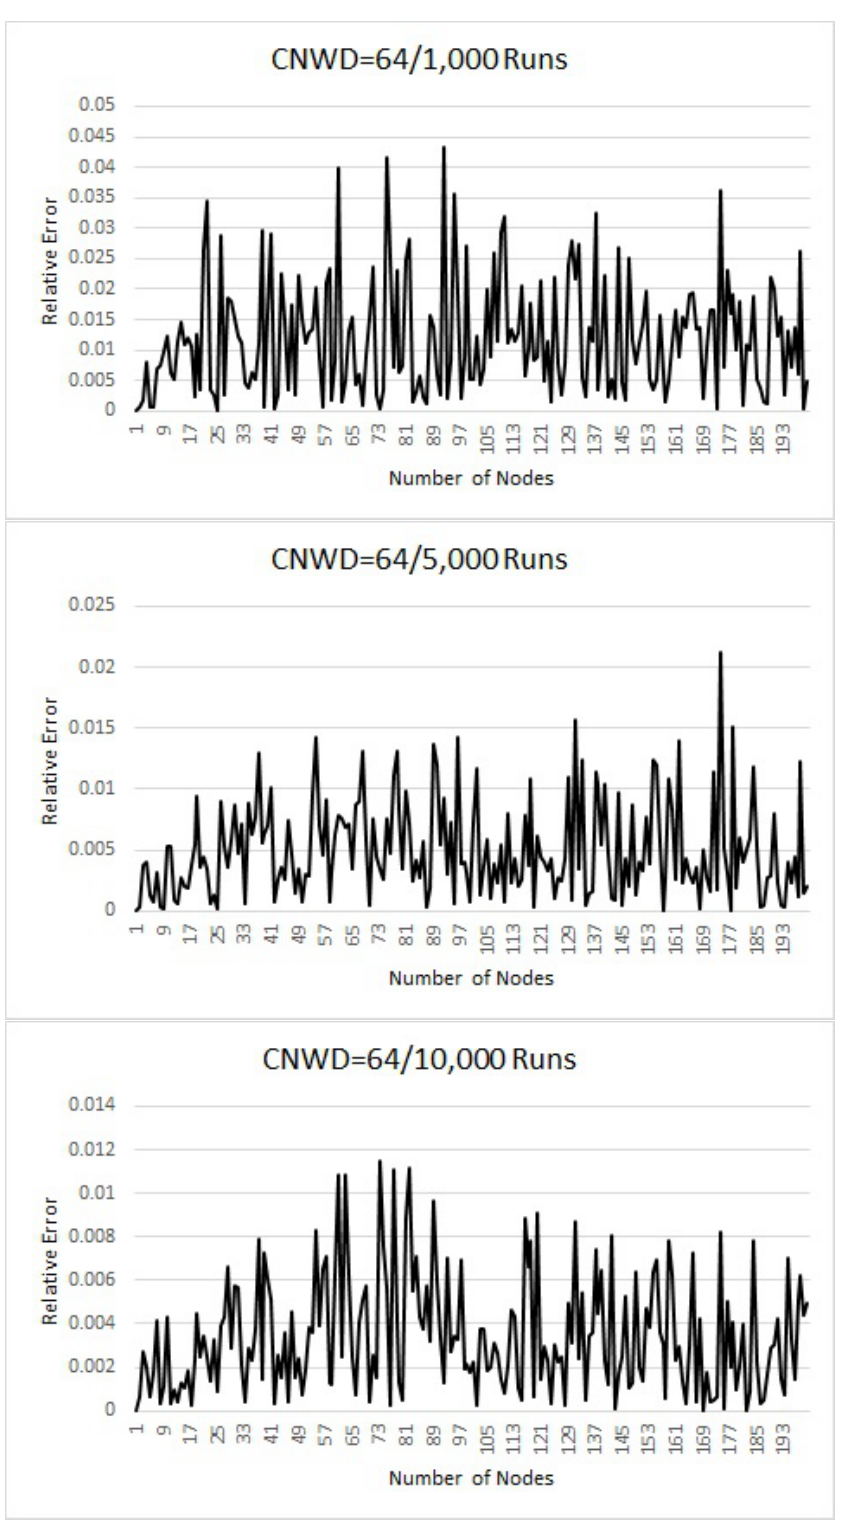
Figure 6. Theoretical vs. Simulated results for CNWD =